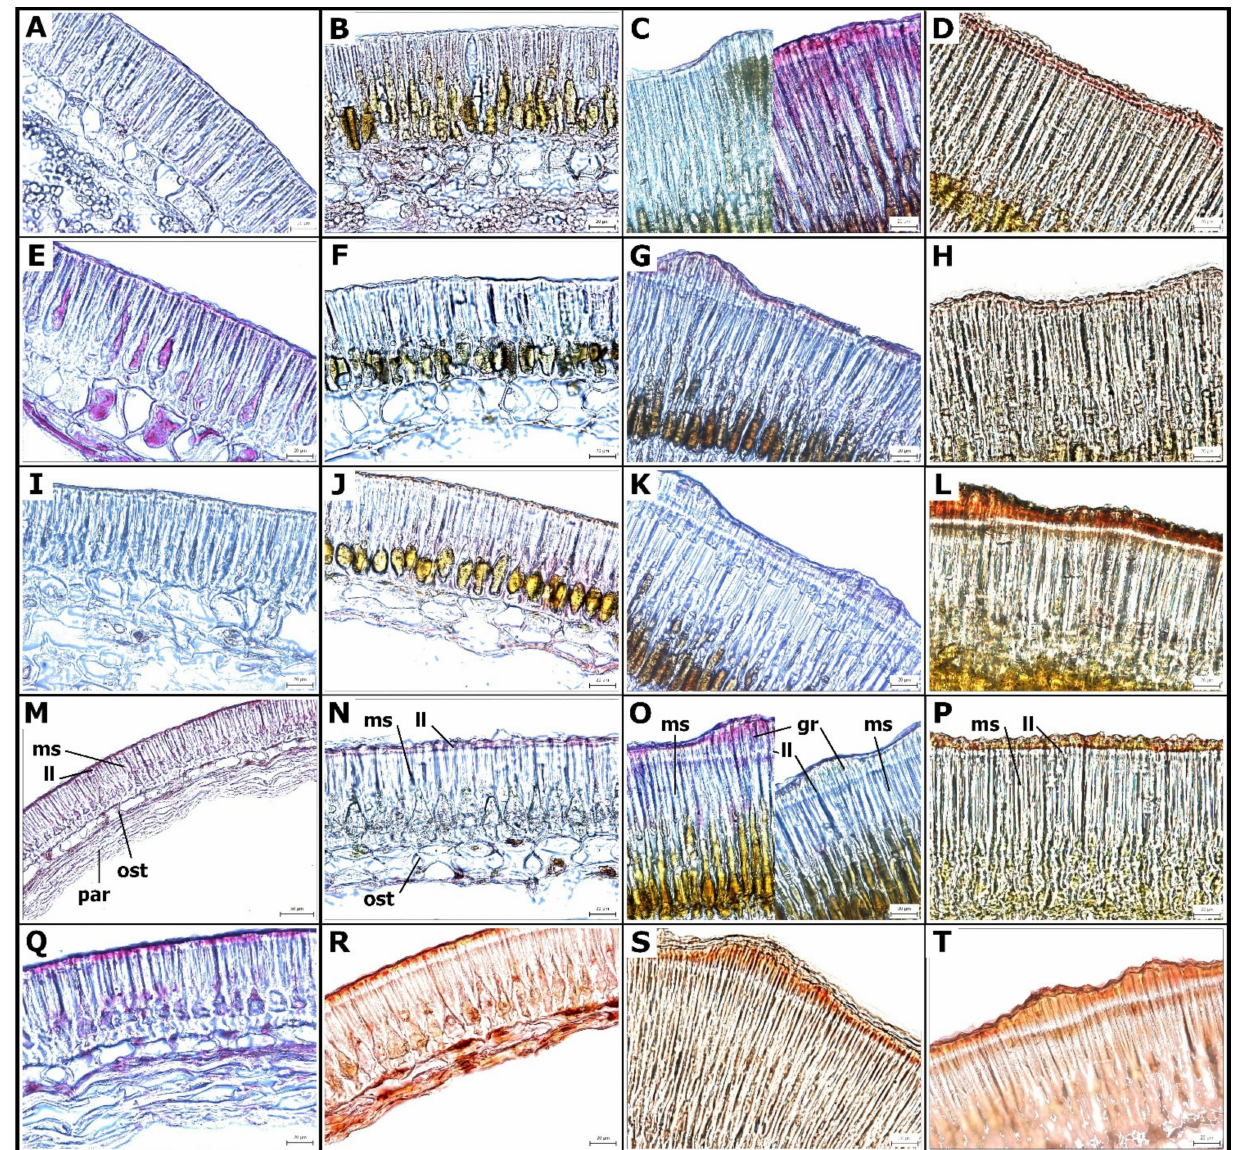
Figure 4. Histochemical Sudan Red staining of lipidic substances. Cultivated pea ( Pisum sativum subsp. sativum) : cv. Cameor ( A , E , I , M , Q ), JI92 ( B , F , J , N , R ); wild pea ( Pisum sativum subsp. elatius ): JI64 ( C , G , K , O , S ), JI1794 ( D , H , L , P , T ). Development series were analyzed at 13 DAA ( A – D ), 21 DAA ( E – H ), 27 DAA ( I – L ), 30 DAA ( M – P ), and dry seeds ( Q – T ). Staining variability within one seed segment in genotype JI64, 13 DAA ( C ) and 30 DAA ( O ). Scale bars = 50 µ m. Abbreviations: ms—macrosclereid cells, ost—osteosclereids, par—parenchyma, gr—gritty, ll—light